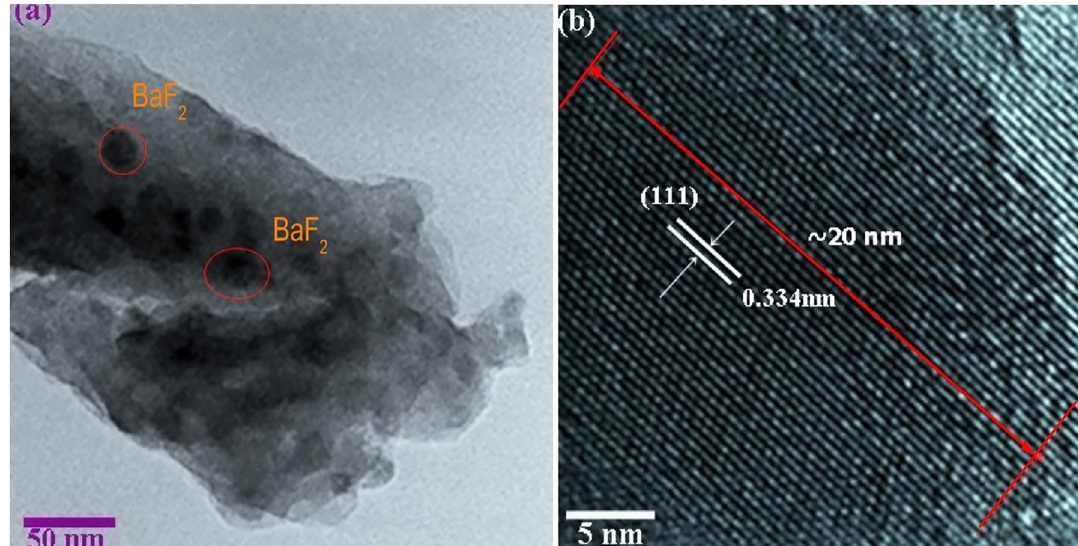
Figure 3. (a) TEM image of SEY-0.2E2.5Y-685 transparent silicate glass-ceramics sample; (b) HRTEM image of SEY-0.2E2.5Y-685 transparent silicate glass-ceramics